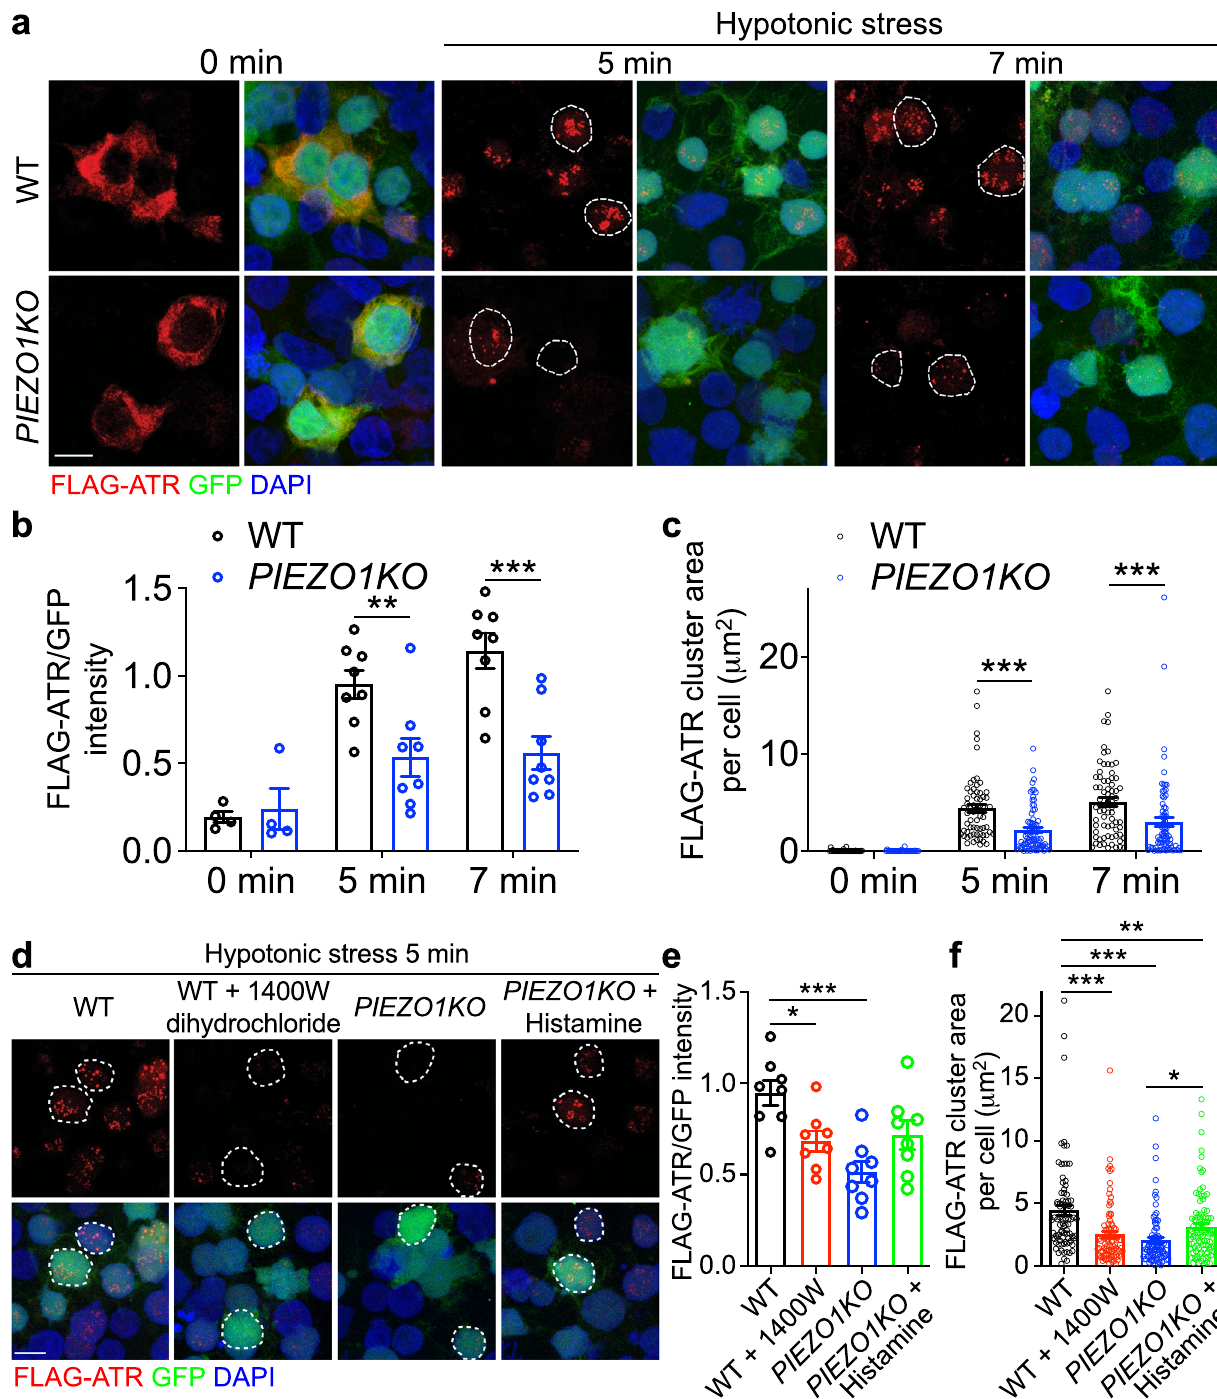
Fig. 6 ATR ’ s response to osmotic stress depends on PIEZO1 and NOS. a – c Hypotonic stress-induced ATR clusters in the nucleus are attenuated in PIEZO1 knockout. a Exogenously expressed FLAG-ATR is present in the cytoplasm in both WT and PIEZO1KO HEK293T cells before treatment. 5 min or 7 min hypotonic stress induces robust clustering of FLAG-ATR in the nucleus in WT cells, which is much attenuated in the PIEZO1KO cells. Fewer cells produce the clusters. The clusters are smaller in size, fewer in number, and lower in intensity. The dashed circles outline the nucleus. Scale bar = 10 μ m. b Quanti fi cation of the fl uorescence intensity of FLAG-ATR normalized to GFP shows a reduction in PIEZO1KO cells. N = 4, 8, and 8 fi elds of view. c Quanti fi cation of the total area of FLAG-ATR clusters in the nucleus per cell is also reduced in PIEZO1KO cells. N = 36, 65, and 70 cells. d – f ATR clustering depends on NOS. d Hypotonic stress-induced ATR clusters in WT HEK293T cells are reduced by the NOS inhibitor 1400 W dihydrochloride, while histamine, a NOS activator, increases ATR clusters in PIEZO1KO cells. The dashed circles outline the nucleus. Scale bar = 10 μ m. e Quanti fi cation of the fl uorescence intensity of FLAG-ATR clusters. N = 8 fi elds of view. f Quanti fi cation of the total area of FLAG-ATR clusters in the nucleus per cell. N = 86, 94, 87, and 97 cells. Data are presented as mean values + / − SEM. * P < 0.05, ** P < 0.01, *** P < 0.001 by two-way ANOVA followed by Sidak ’ s test ( b and c ), one-way ANOVA followed by Tukey ’ s multiple comparisons test ( e and f ). Source data are provided as a Source data fi le.